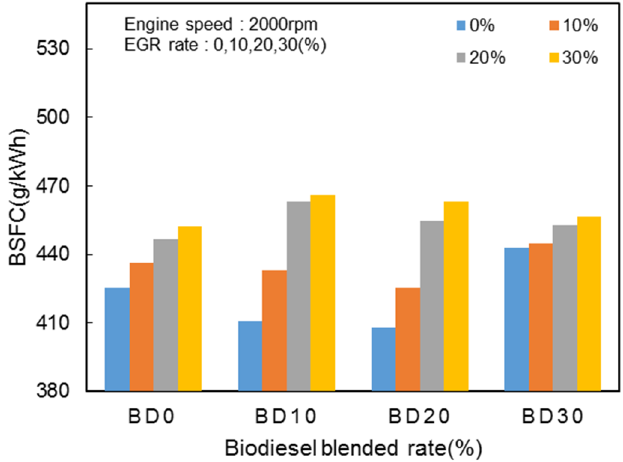
Figure 9. Effects of EGR and the biodiesel blend ratio on the BSFC.